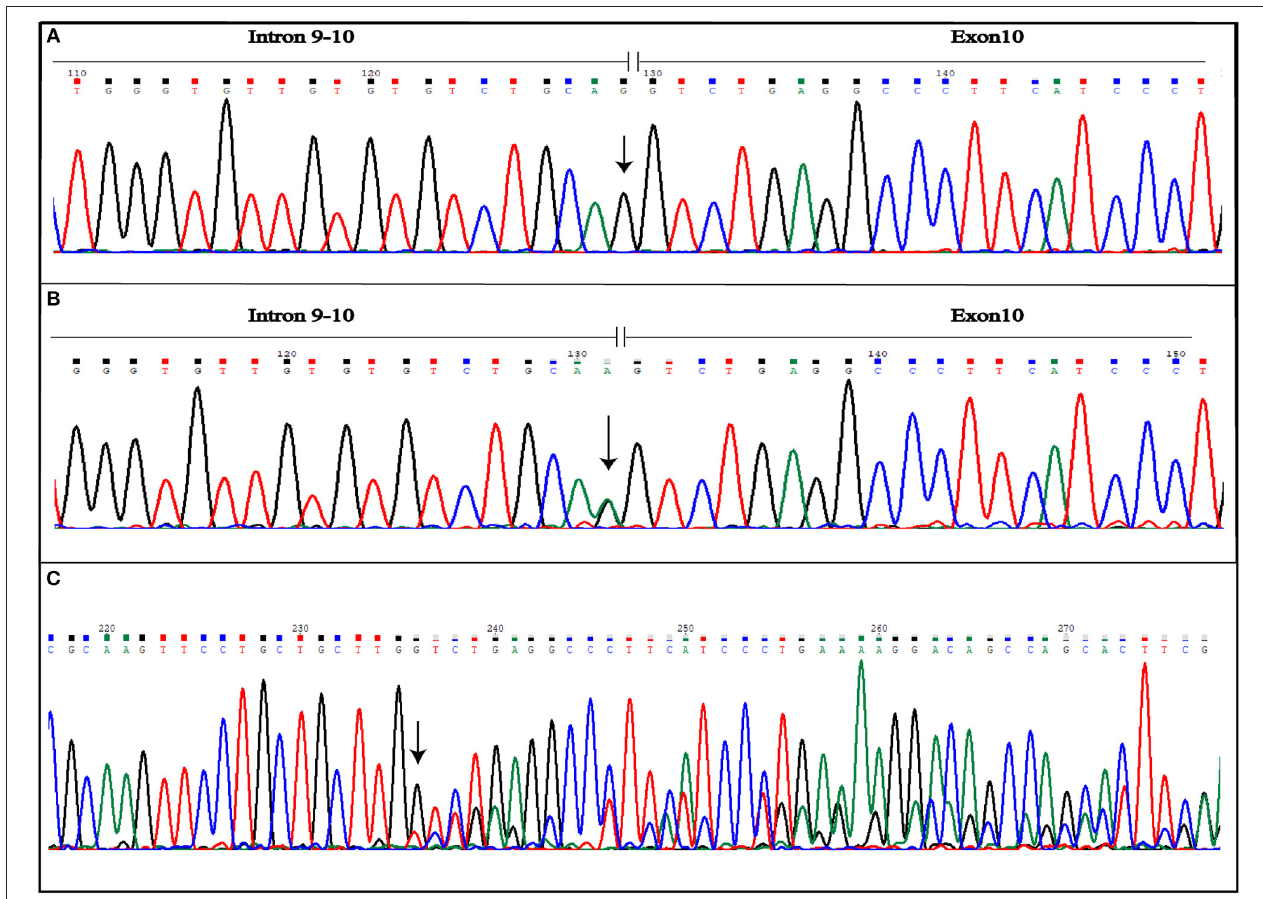
FIGURE 4 | Novel IVS10-1G > A mutation detected in CCM2 gene. The figure shows both wild-type (A) and mutated (B) electropherograms. The heterozygous substitution is indicated by the arrow. The novel heterozygous variant causes splicing alteration that occurs including also the first nucleotide of exon 10, as shown by frameshift observed in electropherogram of the coding sequence (C) . The arrow indicates the point of the